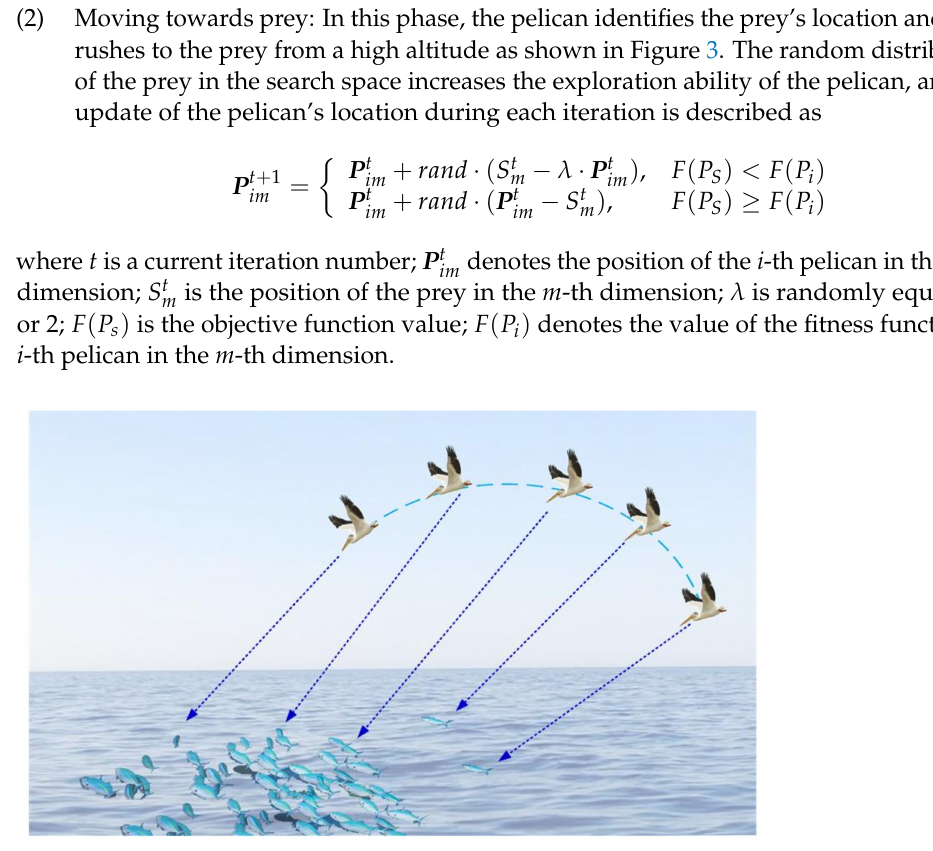
Figure 3. Diagram of the pelicans moving towards